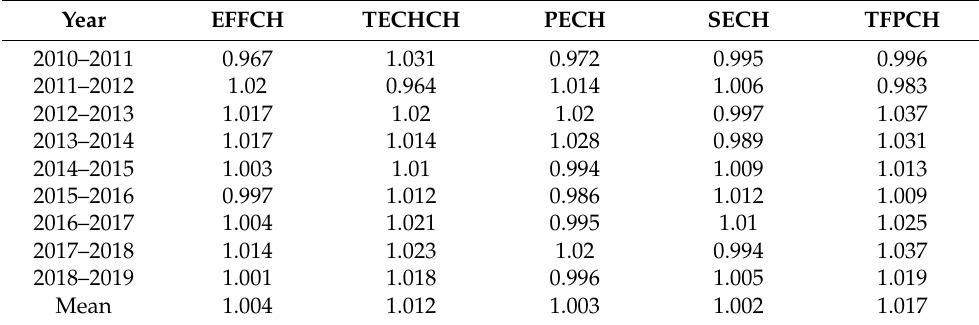
Table 2. Evaluation of unadjusted APE in the YREB from 2010–2019.